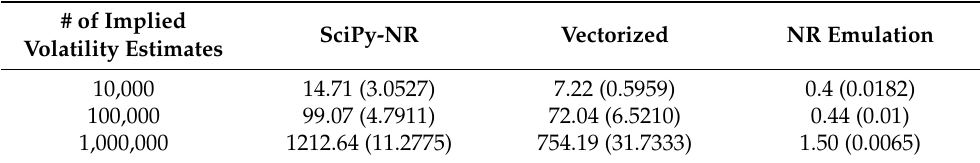
Table 4. Computation times (in milliseconds) for estimating the implied volatility. Each value is calculated by averaging the values from 100 repetitions, and the corresponding standard deviation is provided in parentheses.